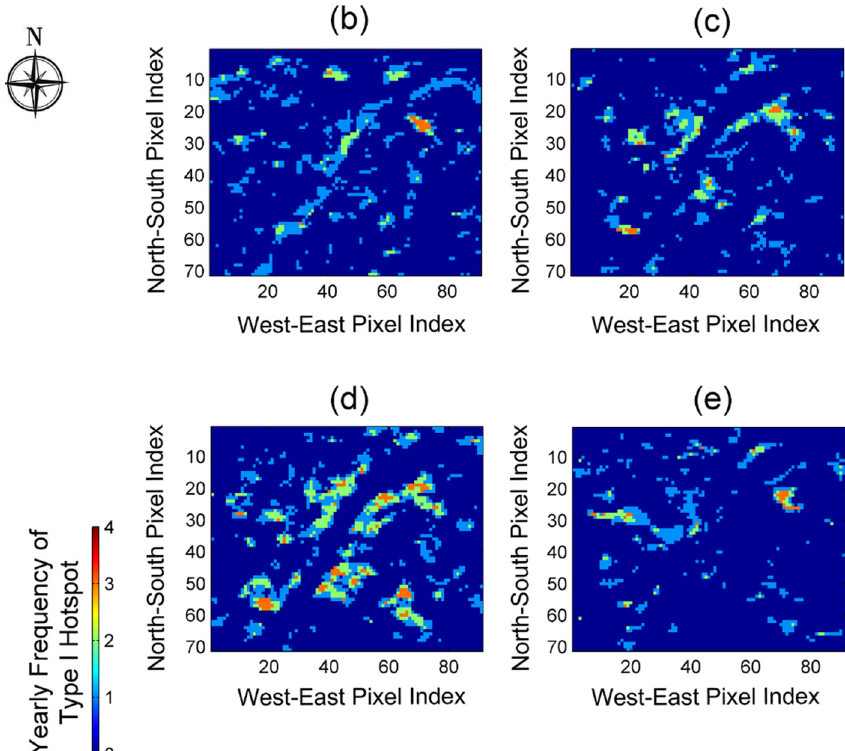
Figure 10. The distribution and frequency of the target hotspots through ( a ) the whole year; ( b ) cold season of December–February; ( c ) warmer season of March–May; ( d ) hot season of June–August; and ( e ) cooler season of September–November.